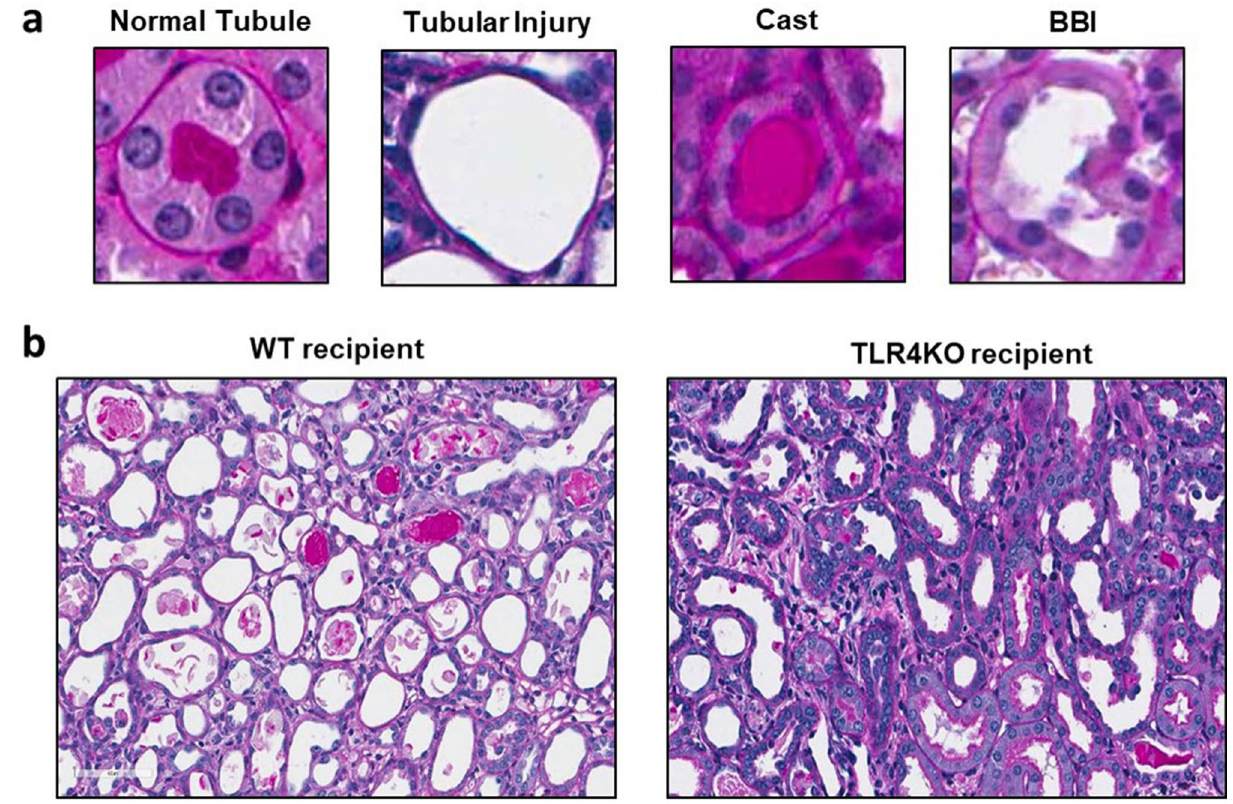
Figure 4. Assessment of tubular injury and cast formation: ( a ) Representative picture of an injured tubule displaying the flattened tubular cells, a cast and a tubule displaying loss of brush border compared to a normal tubule. ( b ) Representative renal histology pictures of transplanted wild type and TLR4 knockout kidneys displaying comparatively less tubular injury and cast formation in TLR4KO kidney recipient compared to WT kidney recipient. However, Brush border injury does not differ much in both the